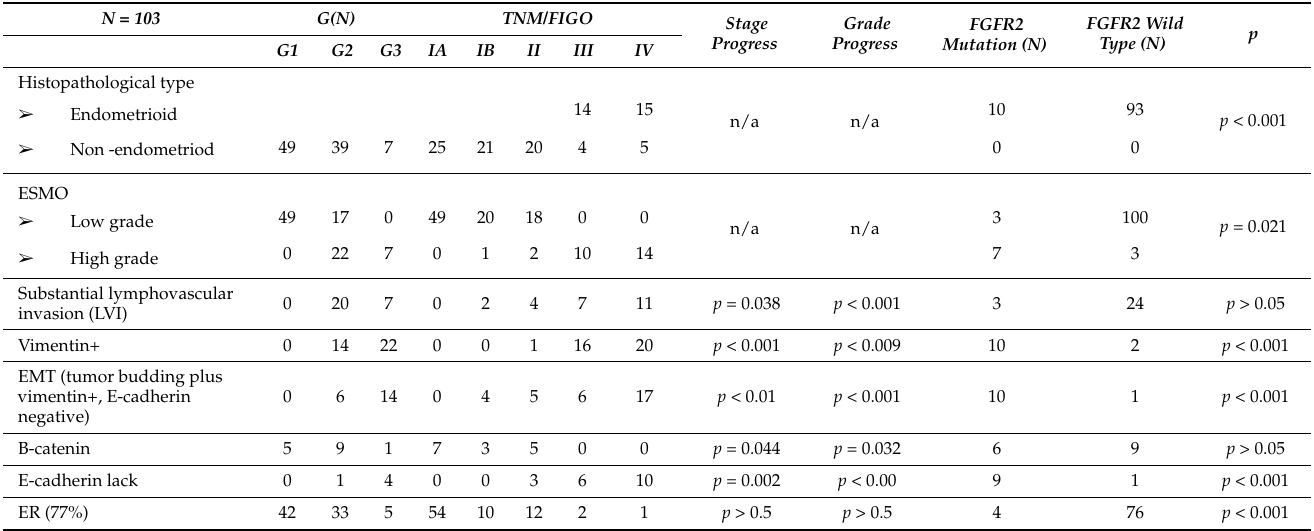
Table 2. Tumor characteristics and expression of targeting proteins according to grade, stage, and FGFR-2